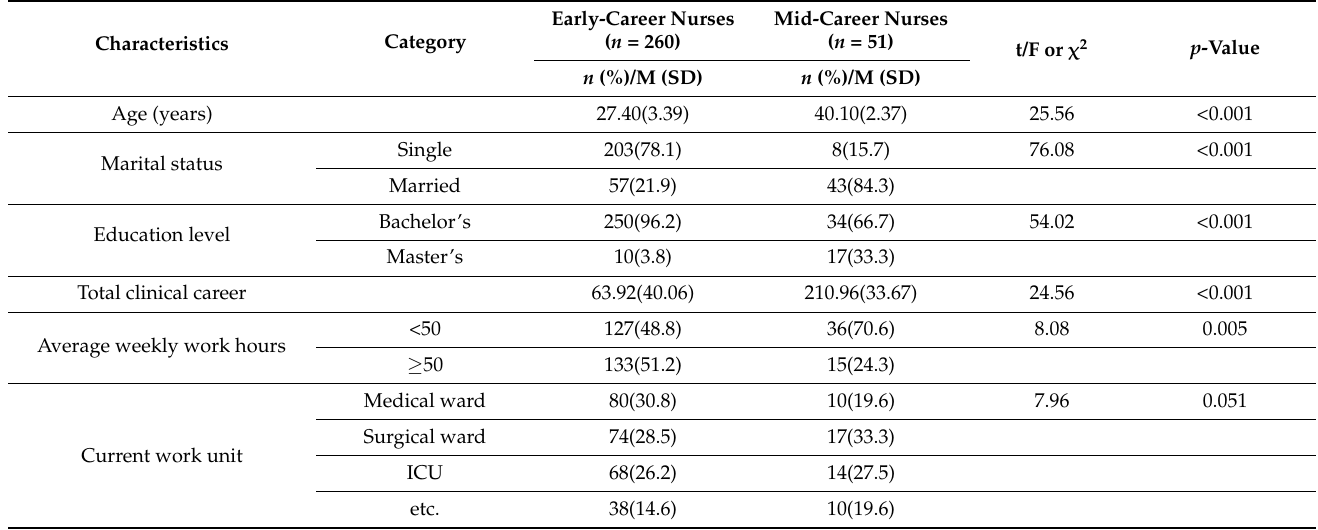
Table 1. General and work-related characteristics ( n = 311).